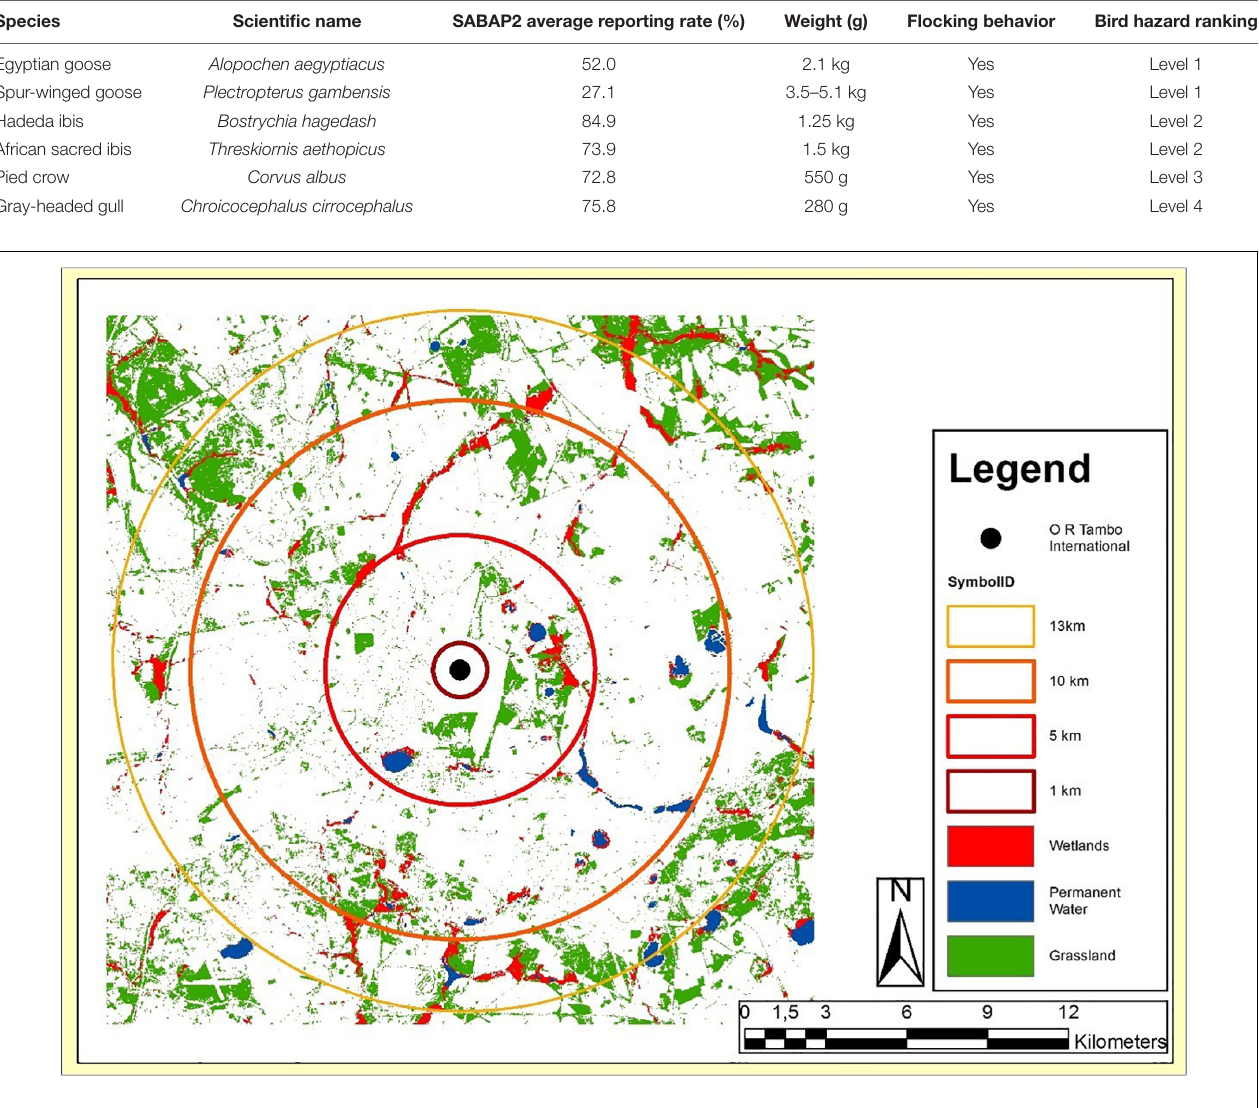
FIGURE 1 | Land-use around OR Tambo International